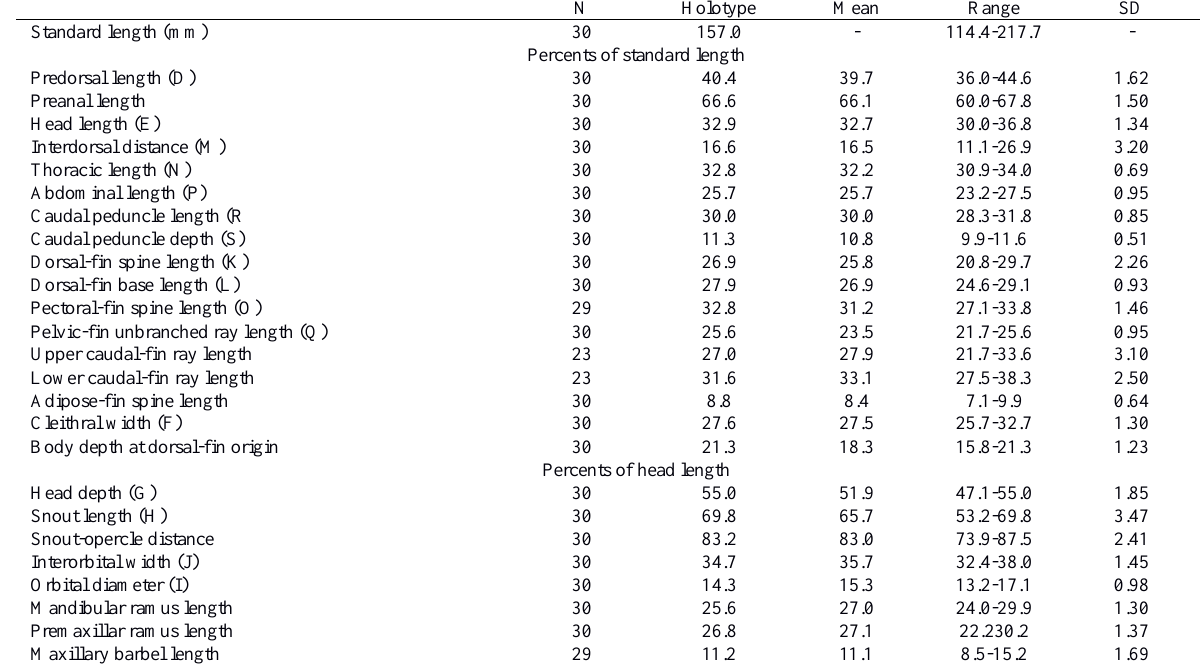
Table 1. Morphometric data of Hypostomus kuarup . Letters in parenthesis follow the abbreviations of Boeseman (1968). N = number of examined specimens, SD = standard